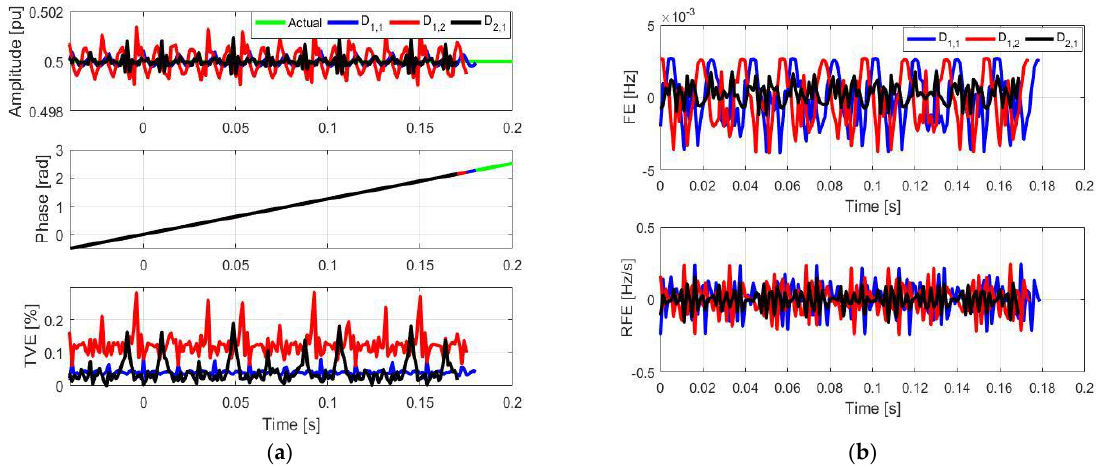
Figure 5. Simulation results obtained for the fundamental component ( 𝑚 = 1 ), for 𝐾 = 1 for 𝐷 1,1 = 16 and 𝐷 1,2 = 20 and 𝐾 = 2 for 𝐷 2,1 = 24 , with 𝑓 1 = 52 Hz and 𝑓 𝑆 = 800 Hz ( 𝑁 = 16) : ( a ) amplitude, phase and TVE, and ( b ) FE and RFE.